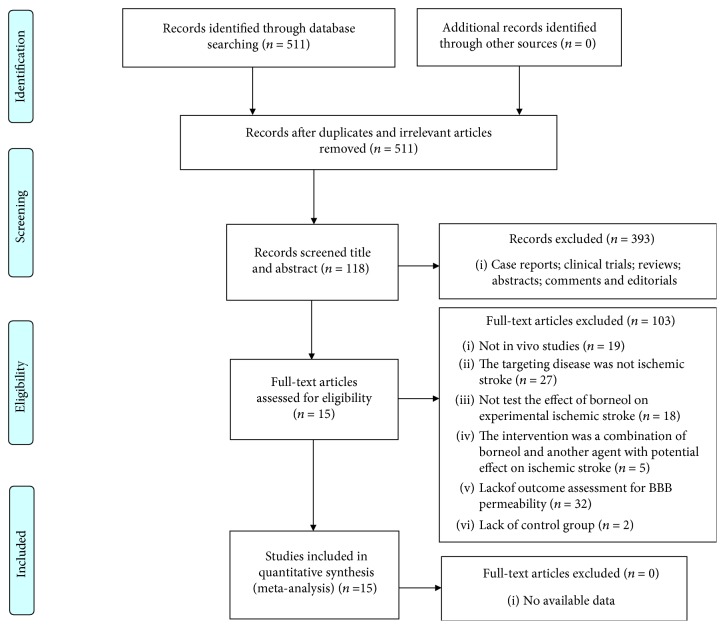
Flow diagram of the search process.